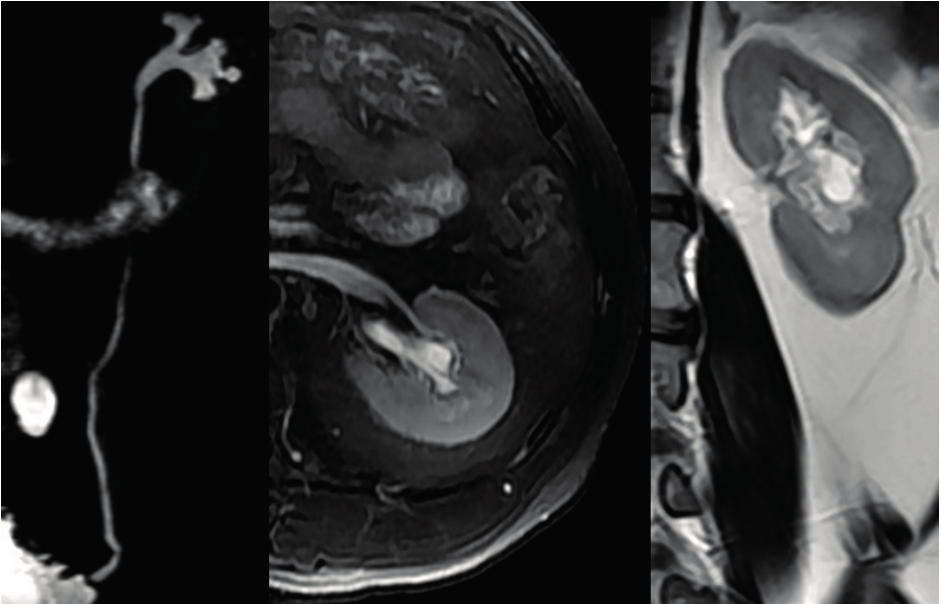
Figure 3. Grade 1 with UUTD-MRU grading